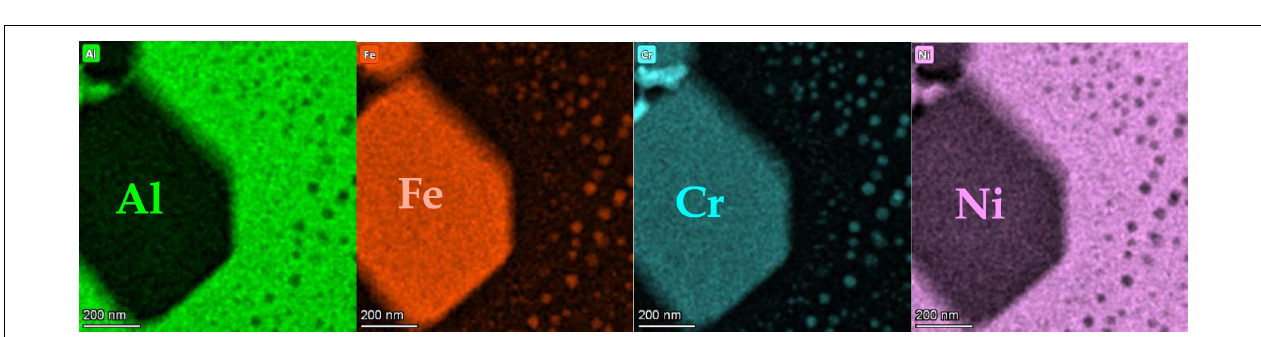
FIGURE 4 | High Resolution S/TEM EDS map (STEM mode) of the area captured in Figure 3A in the as-cast AlCrFe 2 Ni 2 alloy.